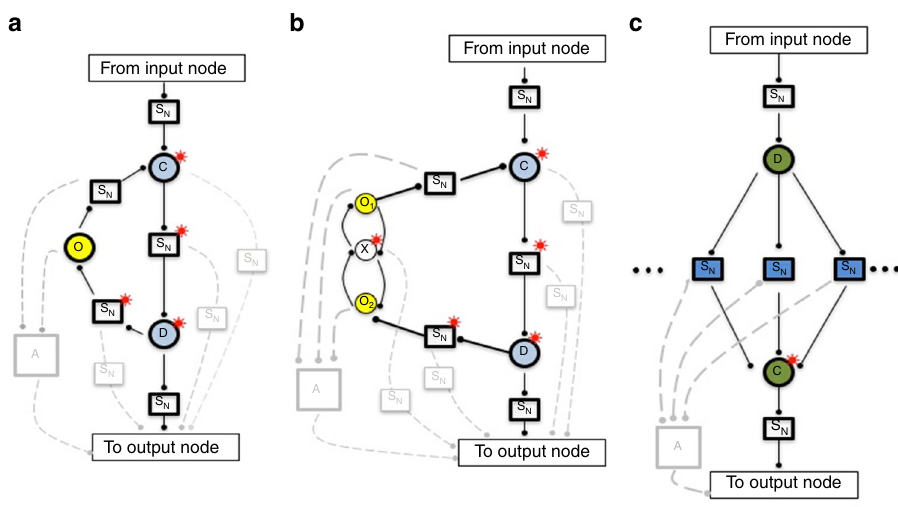
Fig. 5 Outgoing regulations from RPA basis modules. The RPA basis modules from the point of view of potential outgoing regulations from each of the nodes that comprise the active part of the module. Any node that exhibits the RPA property (indicated with a red superposed asterisk) can produce a blind regulation: these can lead directly or indirectly to the output node without affecting the RPA-capability of the network. They can also regulate other RPA Basis Modules embedded in the larger networks without affecting the RPA-capacity of those modules. Any node within the module that does not exhibit the RPA property, on the other hand, can produce only a live regulation. Live outgoing regulations correspond to routes in the network that are not opposed/balanced by the module they feed out of. As such, they require an ancillary module to balance or oppose the live regulation in order for the network as a whole to be RPA-capable. a , b Opposer nodes cannot exhibit RPA. Any outgoing regulations from an opposer node (or any downstream dependents) place that opposer into a route that is not opposed by the associated Opposer Module. Such an outgoing regulation corresponds to term(s) of the RPA equation which belong to the complement of the independently adapting subset associated to the Opposer Module in question. As such, these outgoing regulations must feed into one or more ancillary RPA basis modules at the position(s) indicated by A. Blind regulations, on the other hand, correspond to terms of the independently adapting subset associated with the Opposer Module in question. These routes may thus be considered part of the module itself. c Balancer nodes do not exhibit the RPA property. Outgoing regulations from these nodes are necessarily live regulations, which correspond to the balancer node(s) in question participating in routes other than those that are balanced by the Balancer Module in question. These other routes are thus represented in the RPA equation in the complement of the independently adapting subset associated to the Balancer Module in question. As such, these routes must be balanced/opposed by one or more ancillary modules at the position(s) indicated by